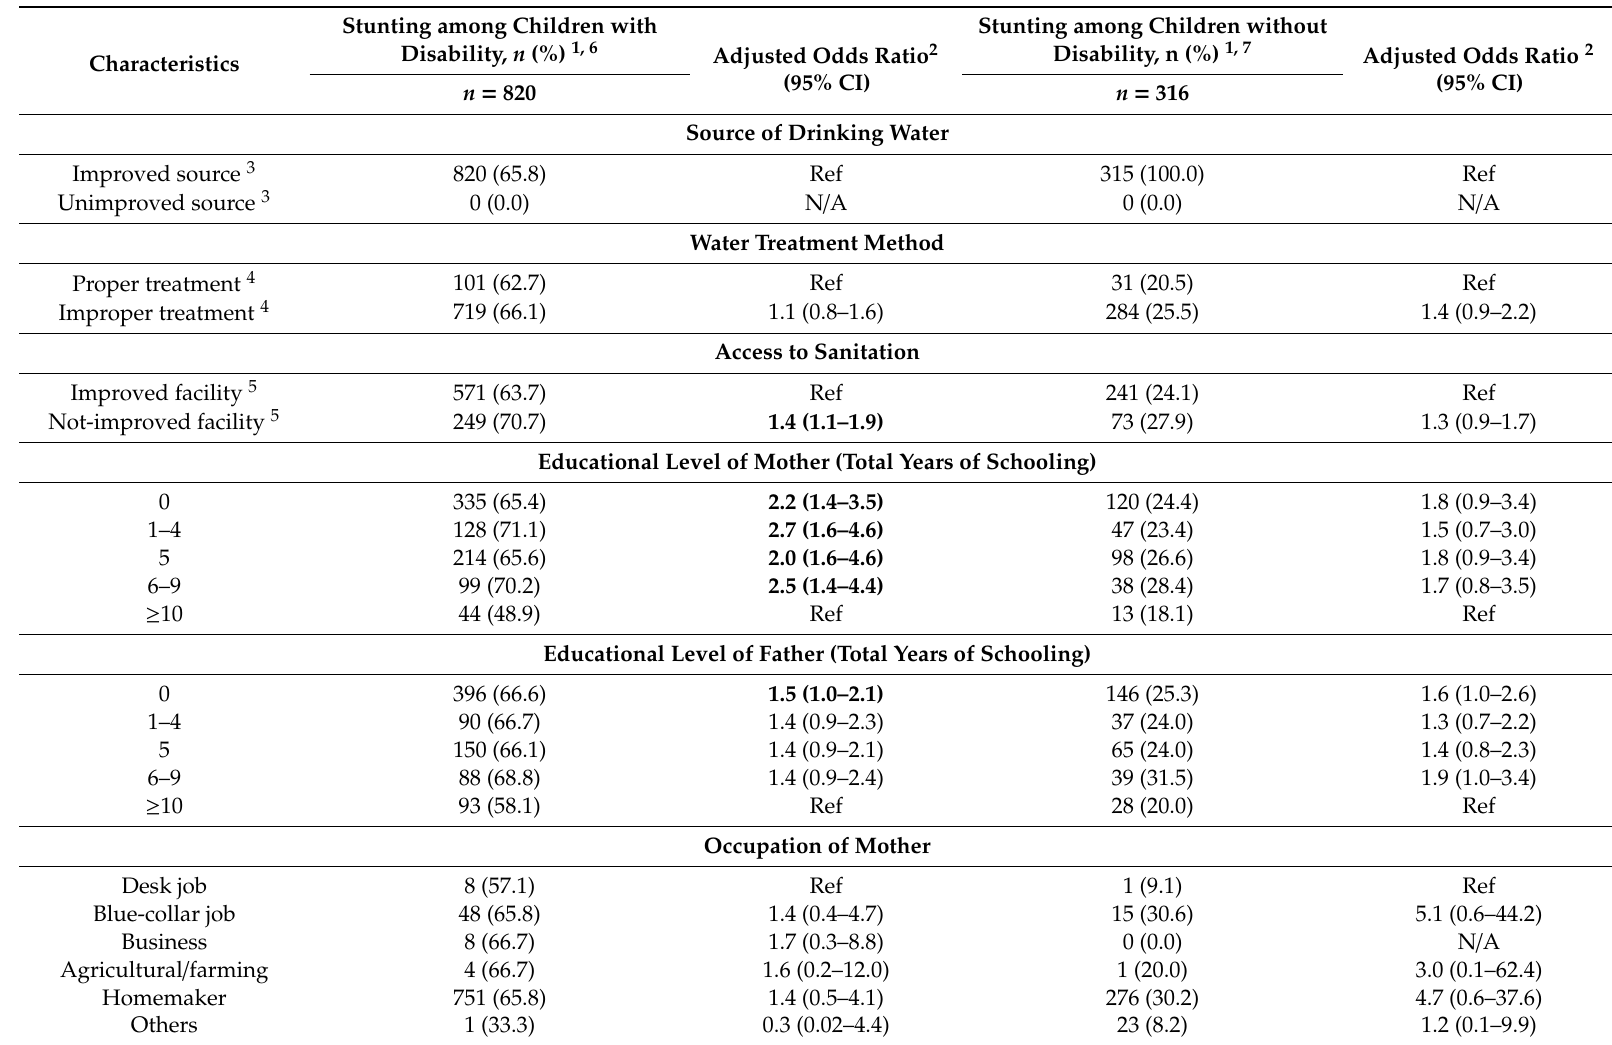
Table 7. Relationship between socioeconomic characteristics and